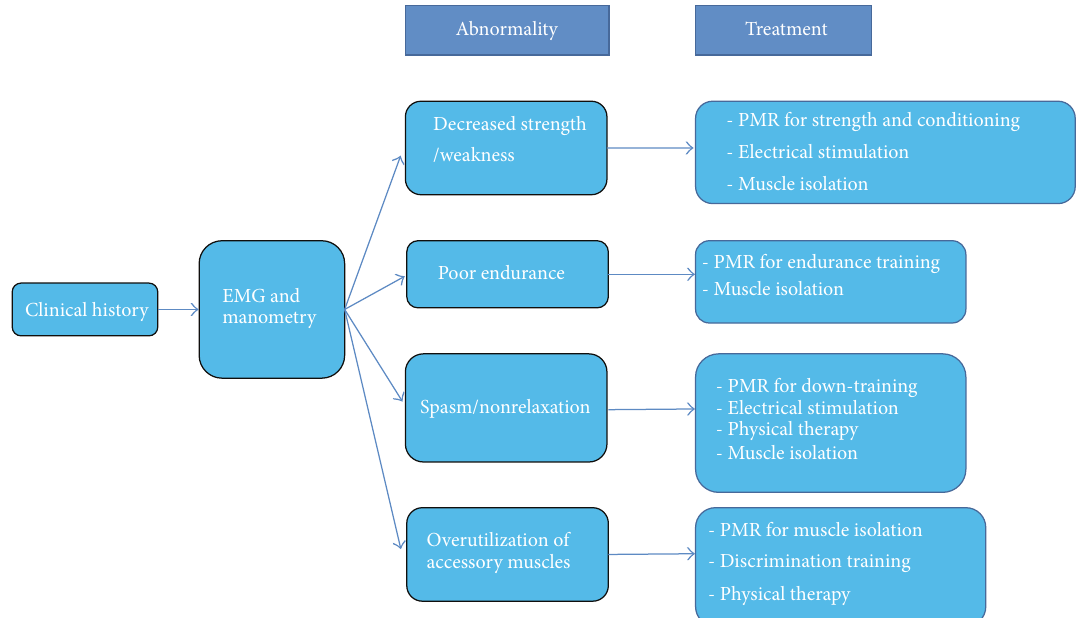
Figure 7: Algorithm illustrating the diagnostic decision tree and treatment approach. Reassessment is performed every time the patient returns for the next